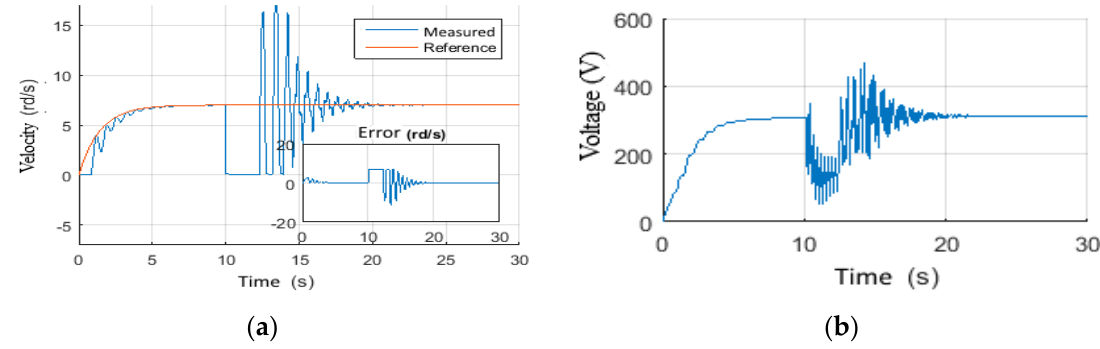
Figure 28. Observer-based controller responses for Scenario-8: ( a ) Wob, ( b ) Torque on bit.